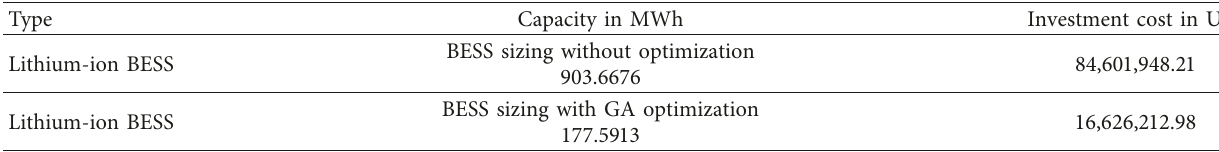
Table 5: BESS sizing without and with